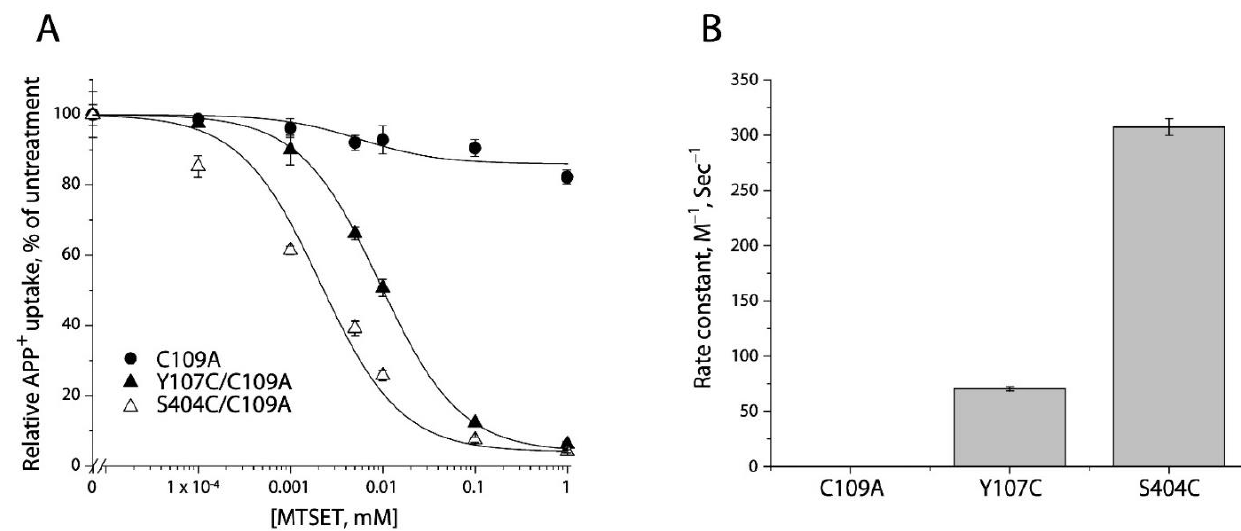
Figure 3. Reactivity of the extracellular cysteine mutants with MTSET. ( A ) MTSET concentration- dependent inhibition of APP + uptake. The cells stably expressing C109A, Y107C/C109C, or S404C/C109A were incubated for 15 min with indicated concentrations of MTSET. The MTSET concentration giving half-maximal inhibition of APP + accumulation in the cells was used to calculate inactivation rate constants as plotted in ( B ). In this experiment, half-maximal MTSET concentrations were >1000 mM for C109A, 0.011 ± 0.006 mM for Y107C/C109A, and 0.0025 ± 0.0008 mM for S404C/C109A, respectively. Representative images of APP + uptake by C109A, Y107C/C109A, or S404C/C109A under various MTSET concentrations were shown in Supplemental Figure S1. The experiment was repeated twice with similar results. ( B ) Rate constants of MTSET inhibition of APP + uptake. At the half-maximal concentration, the half-time is the assay time (15 min) and the first-order rate constant is 7.7 × 10 − 4 s − 1 . This rate constant was divided by the half maximal MTSET concentration from ( A ) to obtain the pseudo first-order modification rate constant. Error bars represent SEM of three experiments.